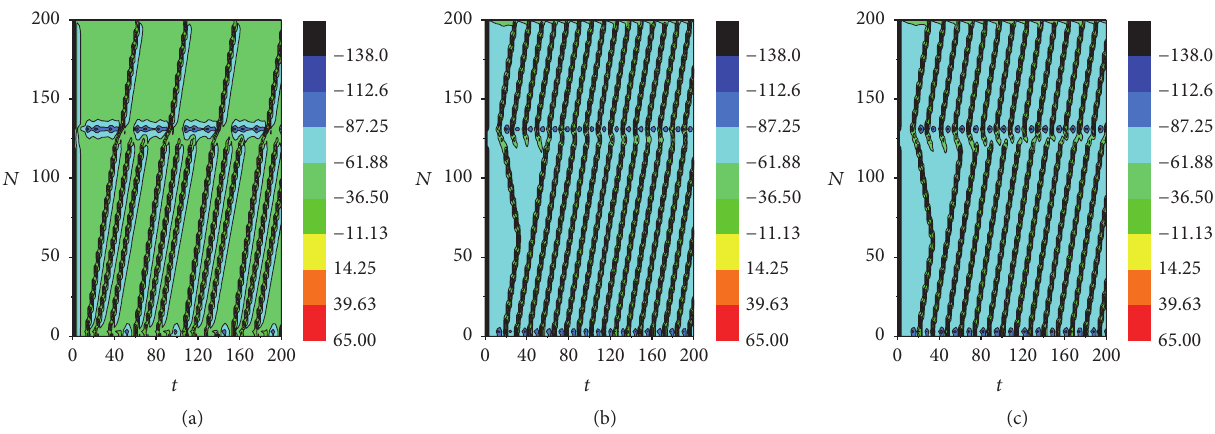
Figure 4: Wave propagation along axon when autapse is developed from node 𝑖 = 3,135 , for time delays (a) 𝜏 = 4 , (b) 𝜏 = 11 , and (c) 𝜏 = 14 : the feedback gain in electric autapse is set as 𝑔 𝑒 = −2.0 and external forcing 𝐼 ext = 20 is imposed on node 𝑖 = 3 . The injured area generated by decreasing the conductance of sodium from 𝐺 Na = 120 mS/cm 2 to 𝐺 Na = 25.5 mS/cm 2 : the axon is divided into 201 nodes and the injured area is marked from nodes 𝑖 = 120 to 130 . The snapshots are illustrated in color scale.